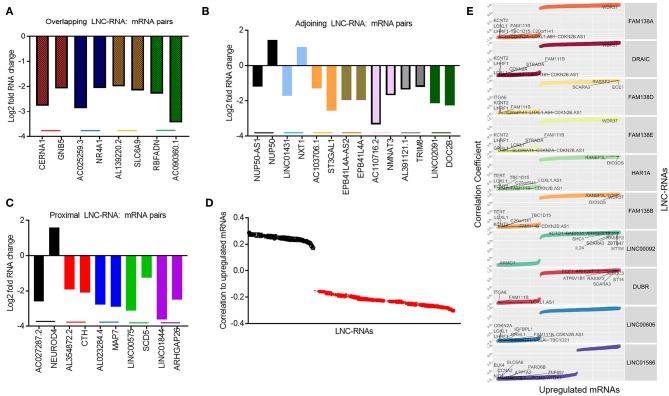
Predicting local and distant potential LNC-RNA: RNA regulation. (A) Graph of significantly changed LNC-RNA: mRNA pairs from overlapping loci. (B) Graph of significantly changed LNC-RNA: mRNA pairs from adjoining loci. (C) Graph of significantly changed LNC-RNA: mRNA pairs from proximal loci. (D) Average correlations of deregulated LNC-RNAs to mRNA changes in Retinoblastoma tumors (Black dots: Average positive correlation, Red dots: Average negative correlation). (E) Examples of deregulated LNC-RNAs (FAM138A, DRAIC, FAM138D, FAM138E, HAR1A, FAM138B, LNC00092, DUBR, LNC00606, and LNC01586) and relative correlation coefficient to coding gene changes.